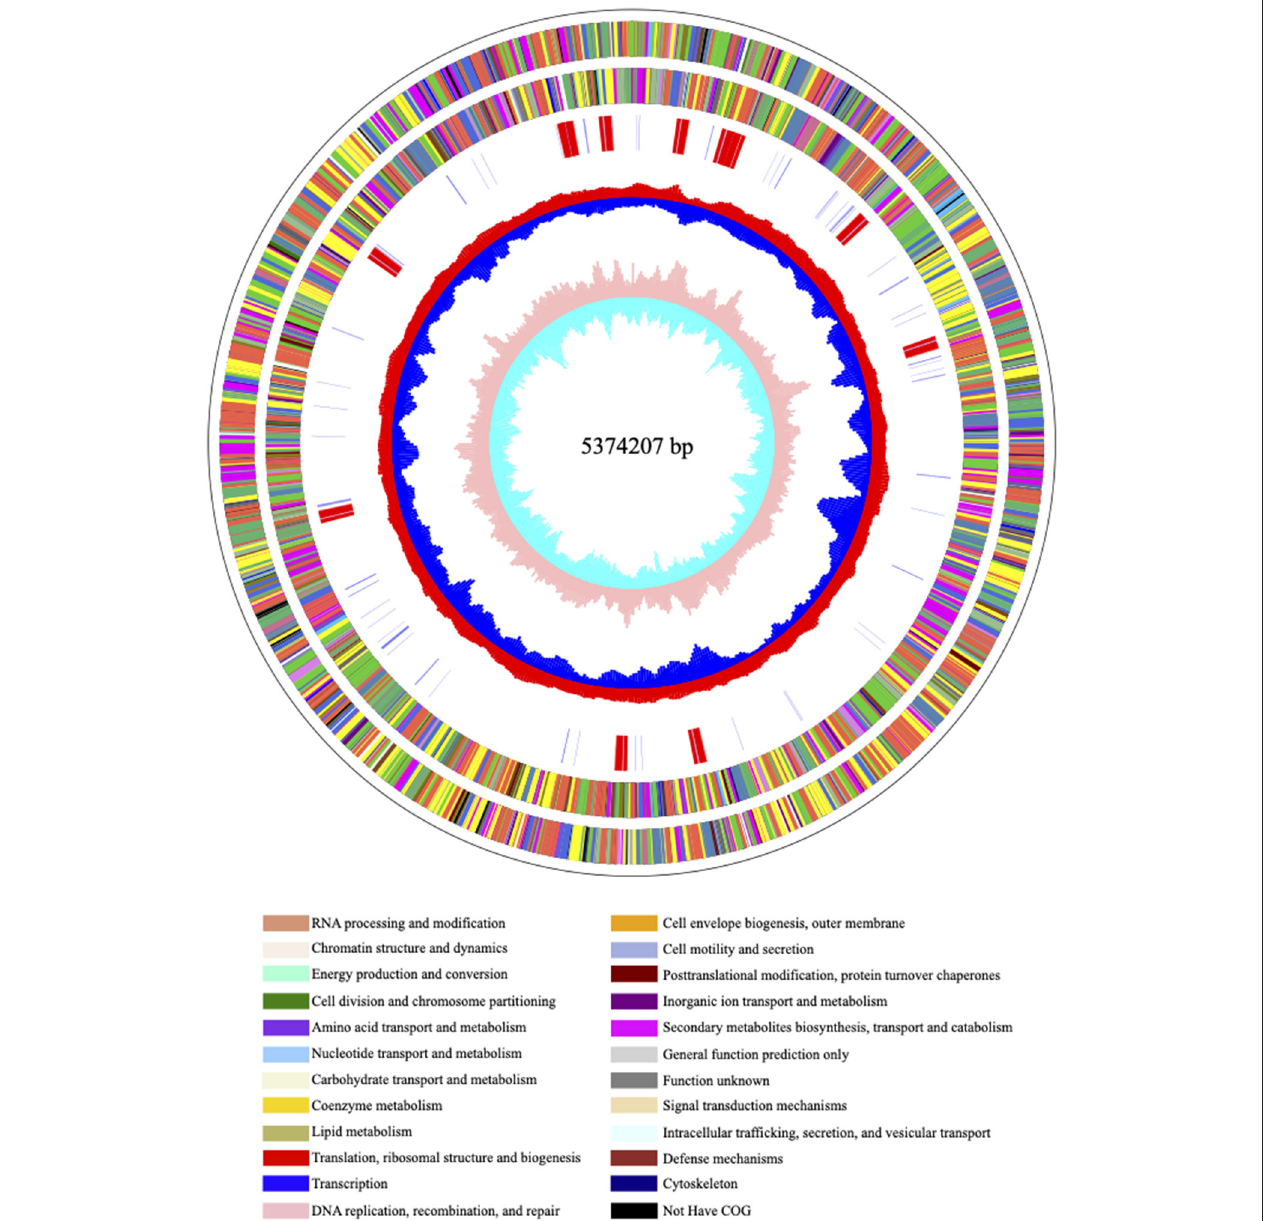
FIGURE 2 | The visual circle map of the chromosome. From outside to inside, the first and second circles are CDS on the positive and negative strands, the third circle is rRNA and tRNA; the fourth circle is the GC content, and the outward red part indicates that the GC content of this region is higher than the average GC content of the whole genome. The higher the peak, the greater the difference from the average GC content, the inward blue part indicates that the GC content of the region is lower than the average GC content of the whole genome, the higher the peak, the greater the difference from the average GC content; the innermost circle (fifth) is the GC skew value, the specific algorithm is G – C/G + C, when the value is positive in the biological sense, the positive chain is more inclined to transcribe CDS, which is a negative value (22, 23).